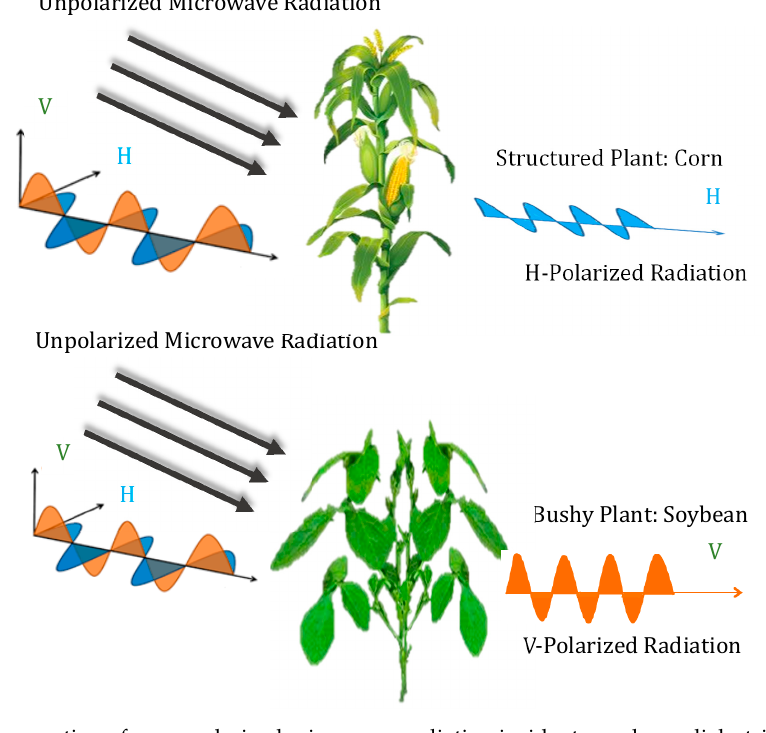
Figure 2. Propagation of an unpolarized microwave radiation incident on a lossy dielectric structured vegetation ( top ) and unstructured/bushy ( bottom ) vegetation. The unpolarized incident wave propagates through structured vegetation emitting H-polarized wave and V-polarized radiation through bushy vegetation.